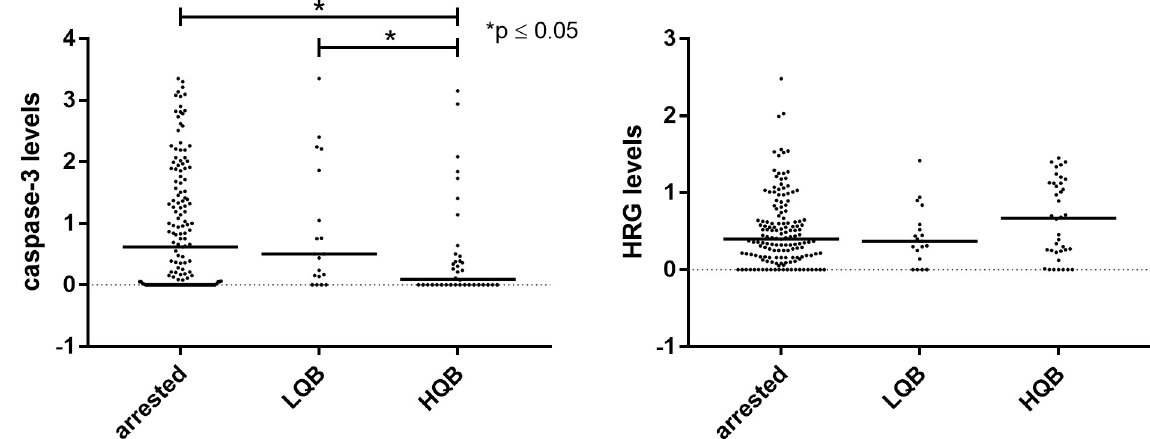
Fig 1. Dot plot of caspase-3 and HRG levels in secretomes from embryos cultured to blastocyst stage. Embryos reaching blastocyst stage were divided into two groups depending on blastocyst quality, i.e. low-quality blastocysts (LQB) and high-quality blastocysts (HQB). The figure shows the relative levels of caspase-3 and HRG in the embryo secretome. The Mann–Whitney U test was used for statistical analysis.